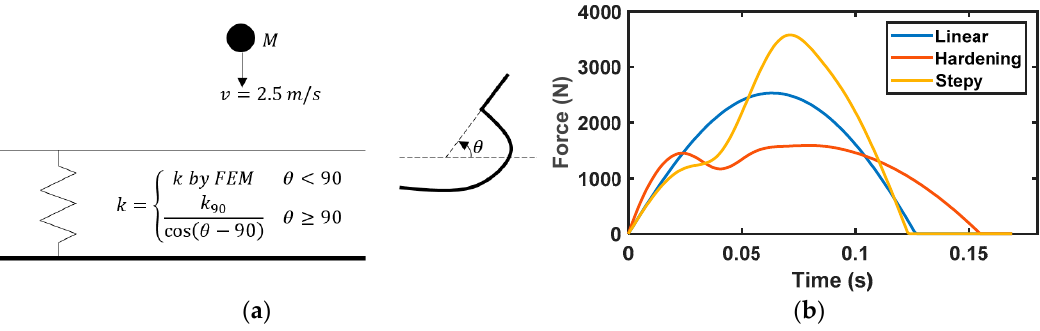
Figure 7. ( a ) Non-linear mass-spring model used to estimate ground reaction forces. 𝜃 , k, 𝑣 , and M represent contact angle, stiffness of spring, vertical velocity at mounting point of prosthesis, and mass of athlete, respectively. 𝑘 (cid:2877)(cid:2868) is stiffness when 𝜃 = 0 ;in other words, when 𝑑 = 0 on the force- displacement curve. ( b ) Estimated vertical ground reaction forces for prostheses having linear, hardening, and stepy force-displacement